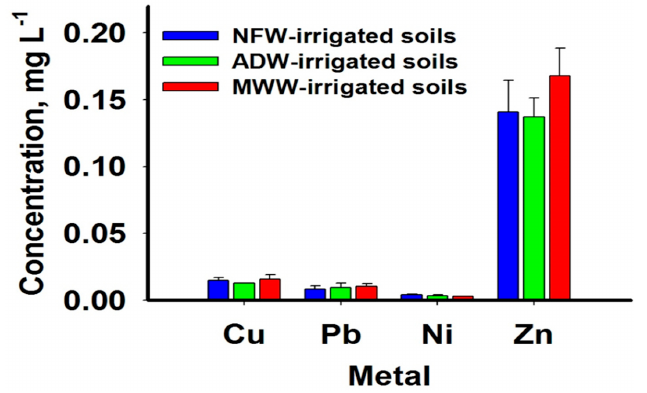
Figure 7. Metal concentrations in groundwater.